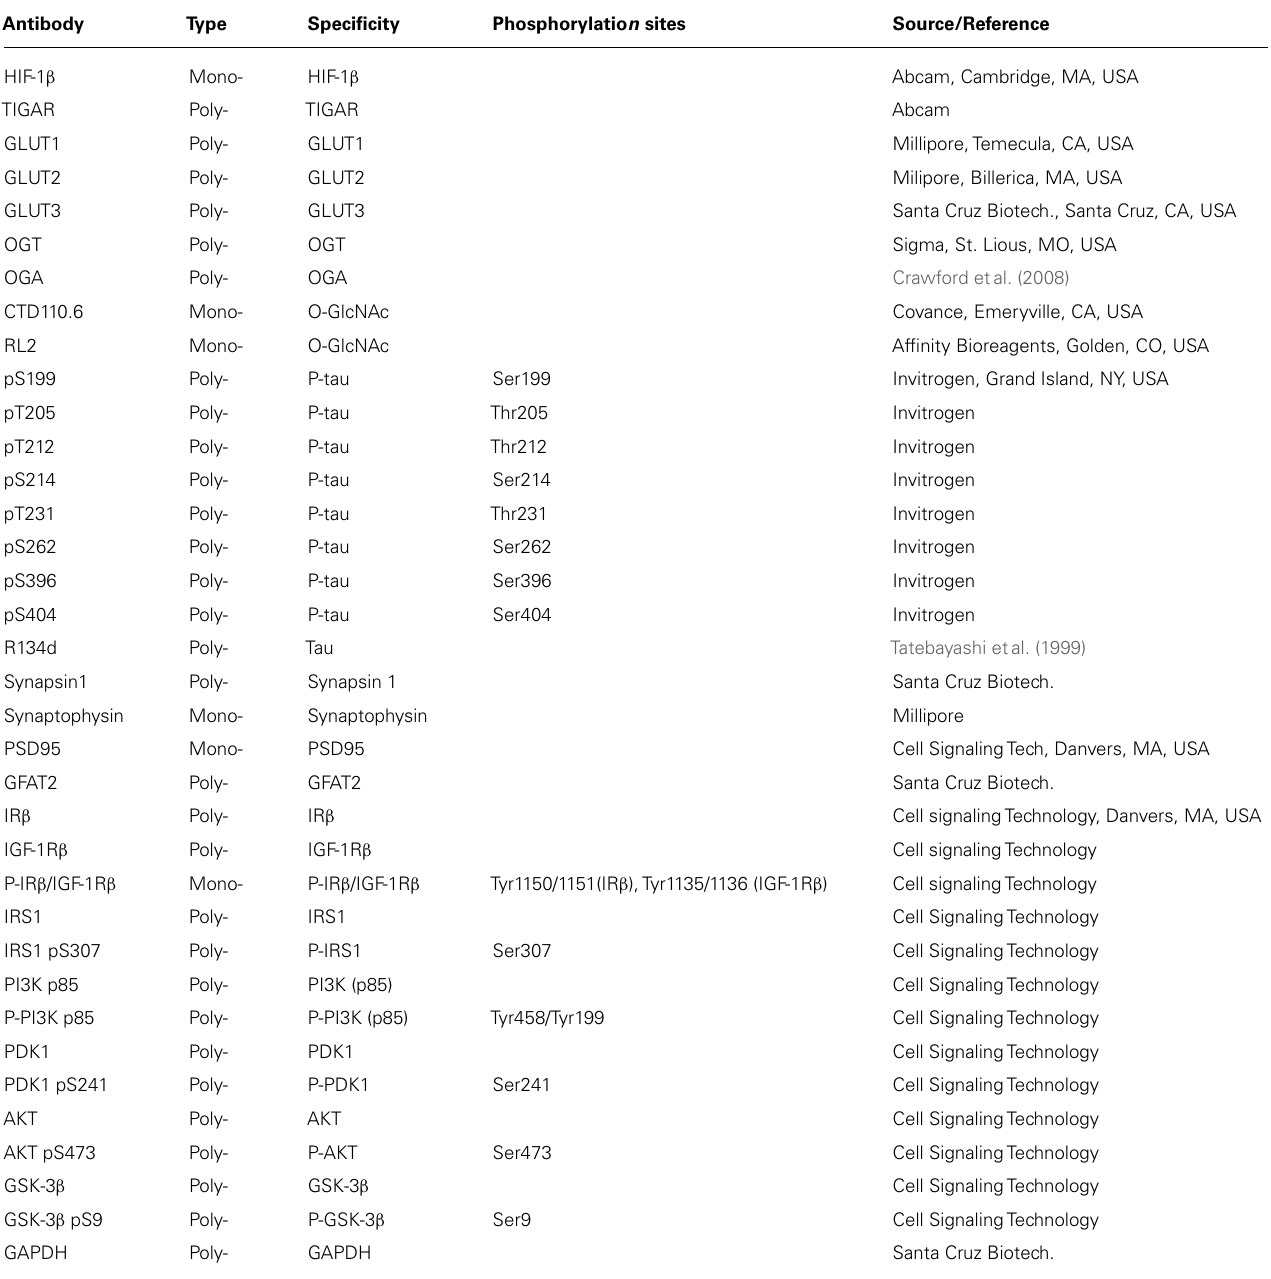
Table 1 | Primary antibodies used in this